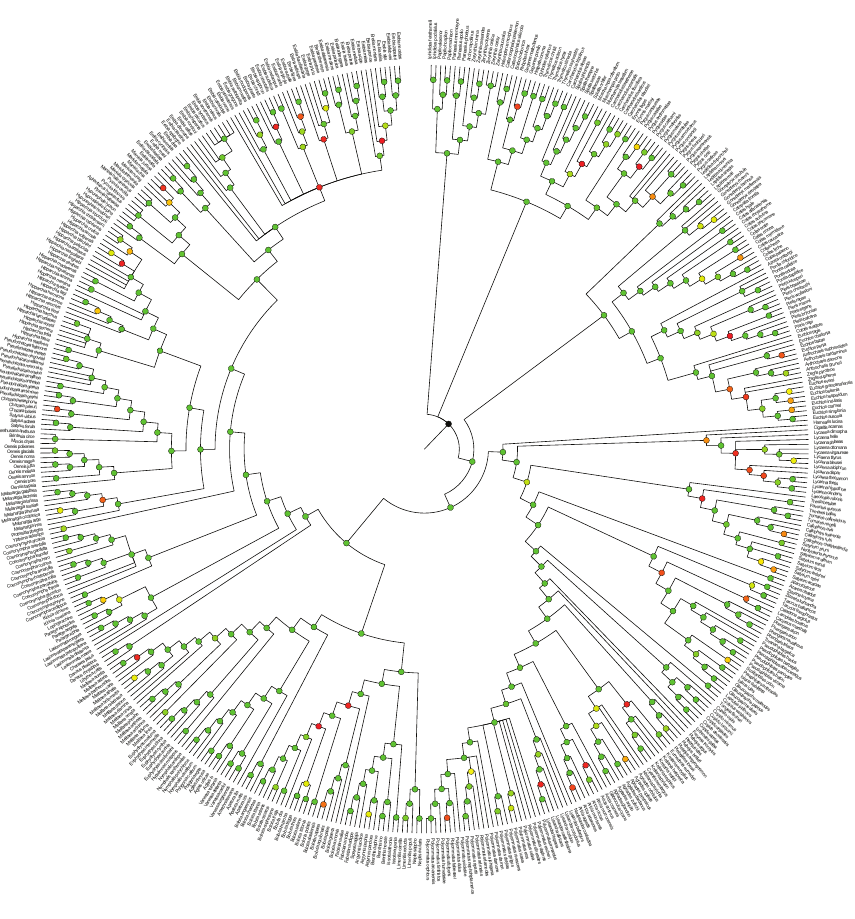
Figure 2. Majority rule consensus tree topology of a set of 1000 trees from the posterior distribution of time-calibrated trees of European butterflies. Circles at the nodes display clade support with a colour gradient from 50% (red) via 75% (yellow) to 100%